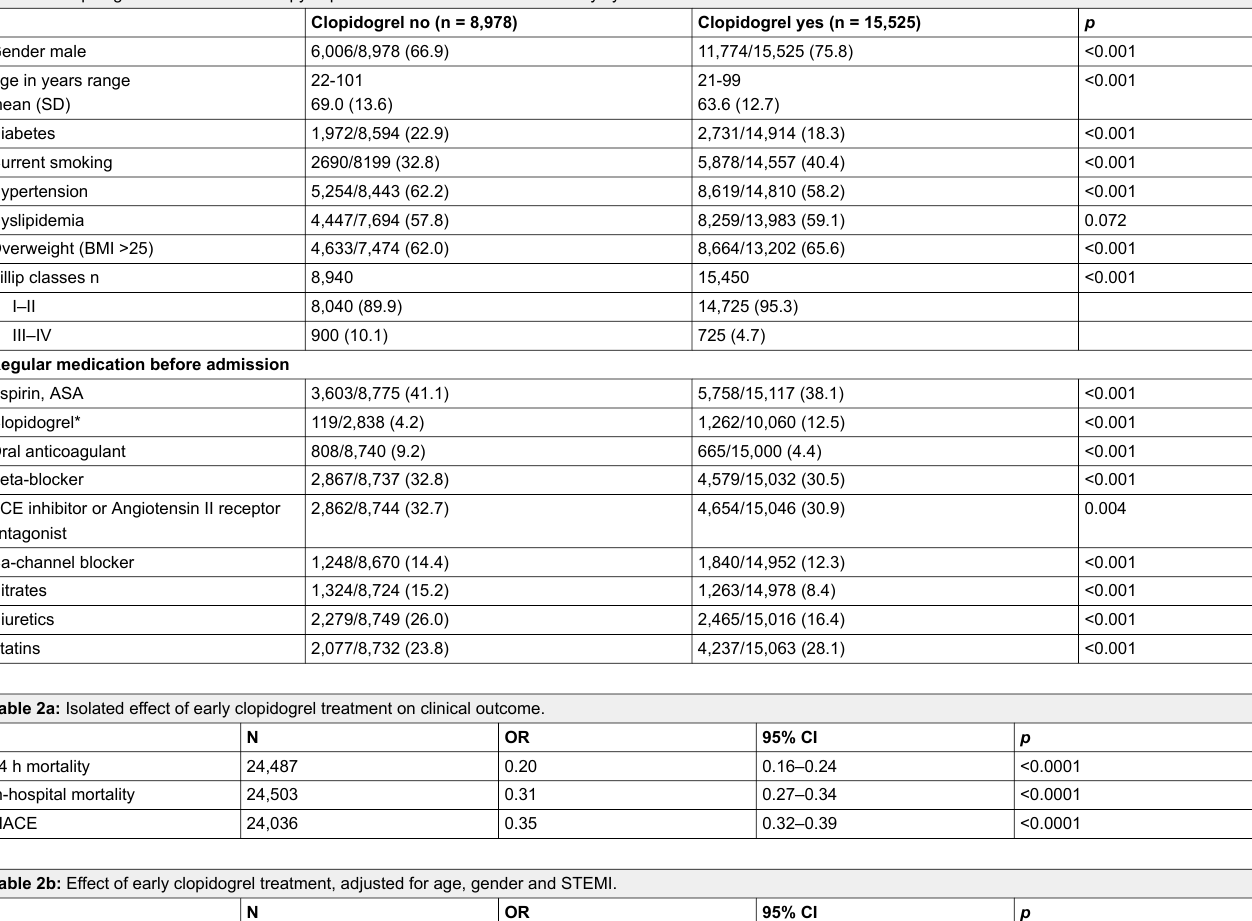
Table 1: Clopidogrel as immediate therapy in patients admitted for acute coronary syndrome between 2000 and 2008.